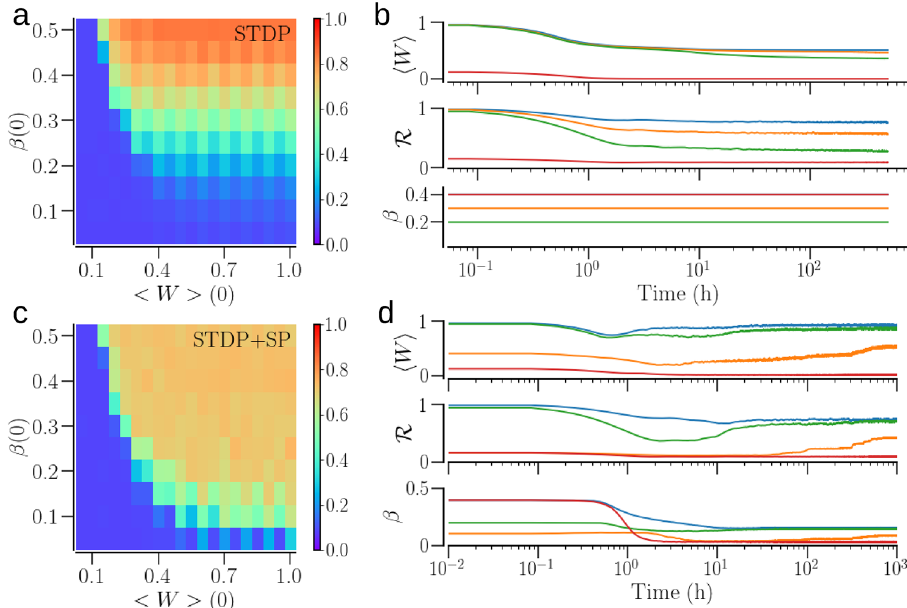
Figure 6. The asymptotic states for a network of non-identical oscillators and their basins of attraction in the two plasticity schemes. The natural frequency of oscillators, ω i , were sampled from the Gaussian distribution. ( a , b ) Refer to a network with STDP only; ( c , d ) corresponds to the network with STDP + SP. The colors in ( a ) and ( c ) indicate the values of the order parameter, R , in the asymptotic states when the system begins with the initial mean synaptic weight and In-NDD given by (cid:31) W (cid:30) ( 0 ) and β( 0 ) . ( b ) and ( d ) Show examples of time evolution of the mean synaptic weight, (cid:31) W (cid:30) , the order parameter, R , and the mean In-NDD, β for different initial conditions (color coded) as the network transitions to a synchronized, desynchronized, or intermediate state, for STDP and STDP + SP, respectively. Parameters are a = 0.3 , γ = 15